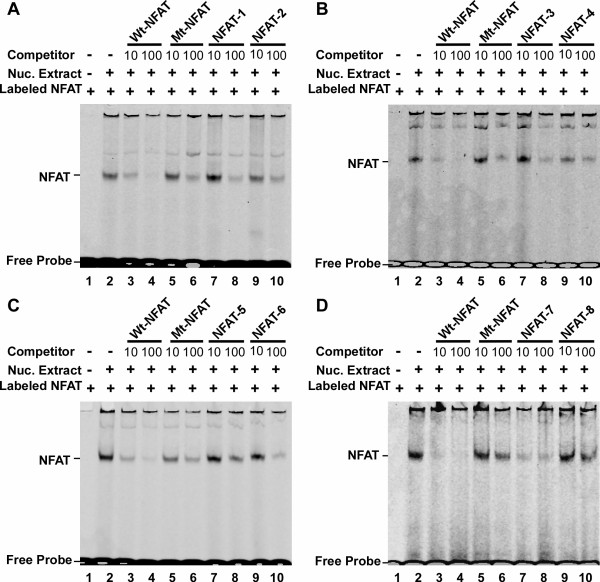
Gel mobility shift assay for the TMP21 gene promoter. Gel shift assays were performed as described in the Material and Methods. Double stranded NFAT oligonucleotide probes labeled wuth IRDye-680 were applied. Lane 1 is labeled probe alone without nuclear extract. Incubation with nuclear extracts retarded the migration rate of the labeled probe, forming a new shifted DNA-protein complex band (lane 2). Competition assays were performed by further adding different concentrations of molar excess of unlabeled competition oligonucleotides, consensus NFAT (lane 3, 4), binding sequence mutant NFAT (lane 5, 6) and TMP21 NFAT elements (lane 7, 8, 9, 10).